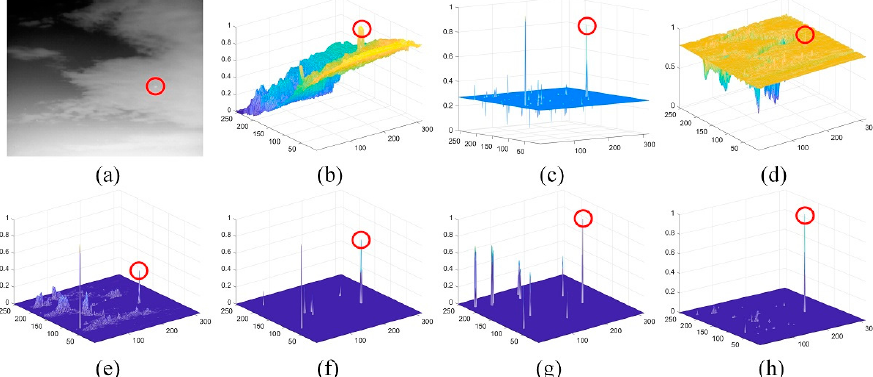
Figure 10. The detection results of different methods on S1: ( a ) the 49th image in S1 and ( b – h ) nor- malized 3-D mesh obtained by the LCM [18], IPI [10], MCPM [19], LIG [22], PSTNN [12], FKRW [15], and the proposed method, respectively.